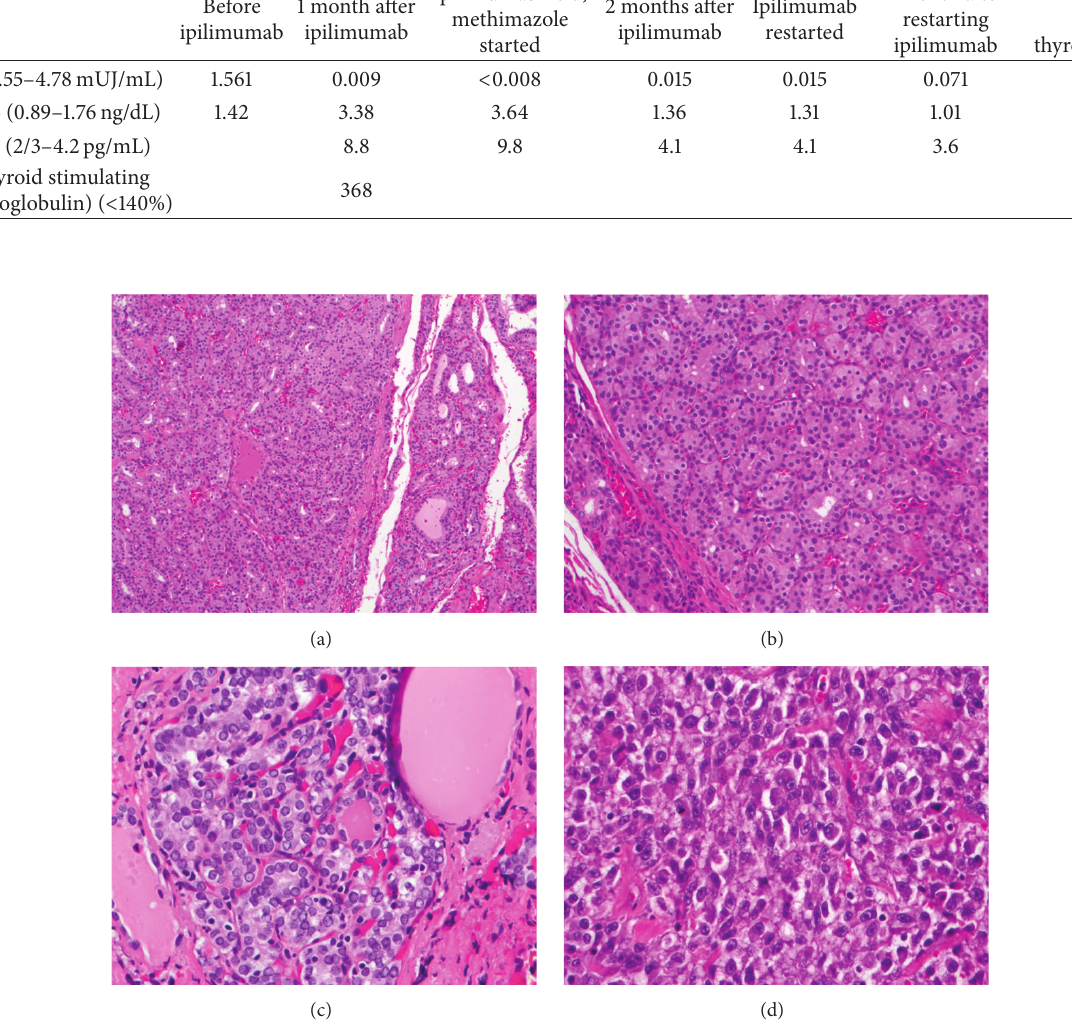
Figure 1: Nodular hyperplasia of the thyroid (a) secondary to the patient’s Graves’ disease, demonstrating abundant follicular structures with scant colloid (b); high power view of patient’s papillary thyroid microcarcinoma demonstrating vesicular nuclei, nuclear grooves, and nuclear crowding (c); and representative discohesive, high grade malignant cells of the patient’s malignant melanoma requiring ipilimumab therapy